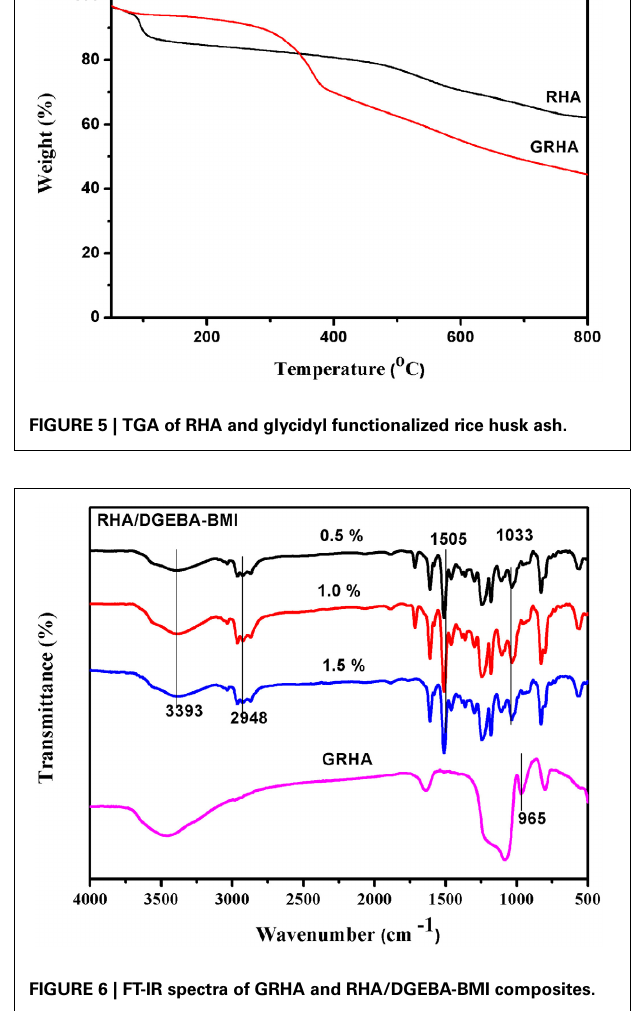
FIGURE 6 | FT-IR spectra of GRHA and RHA/DGEBA-BMI